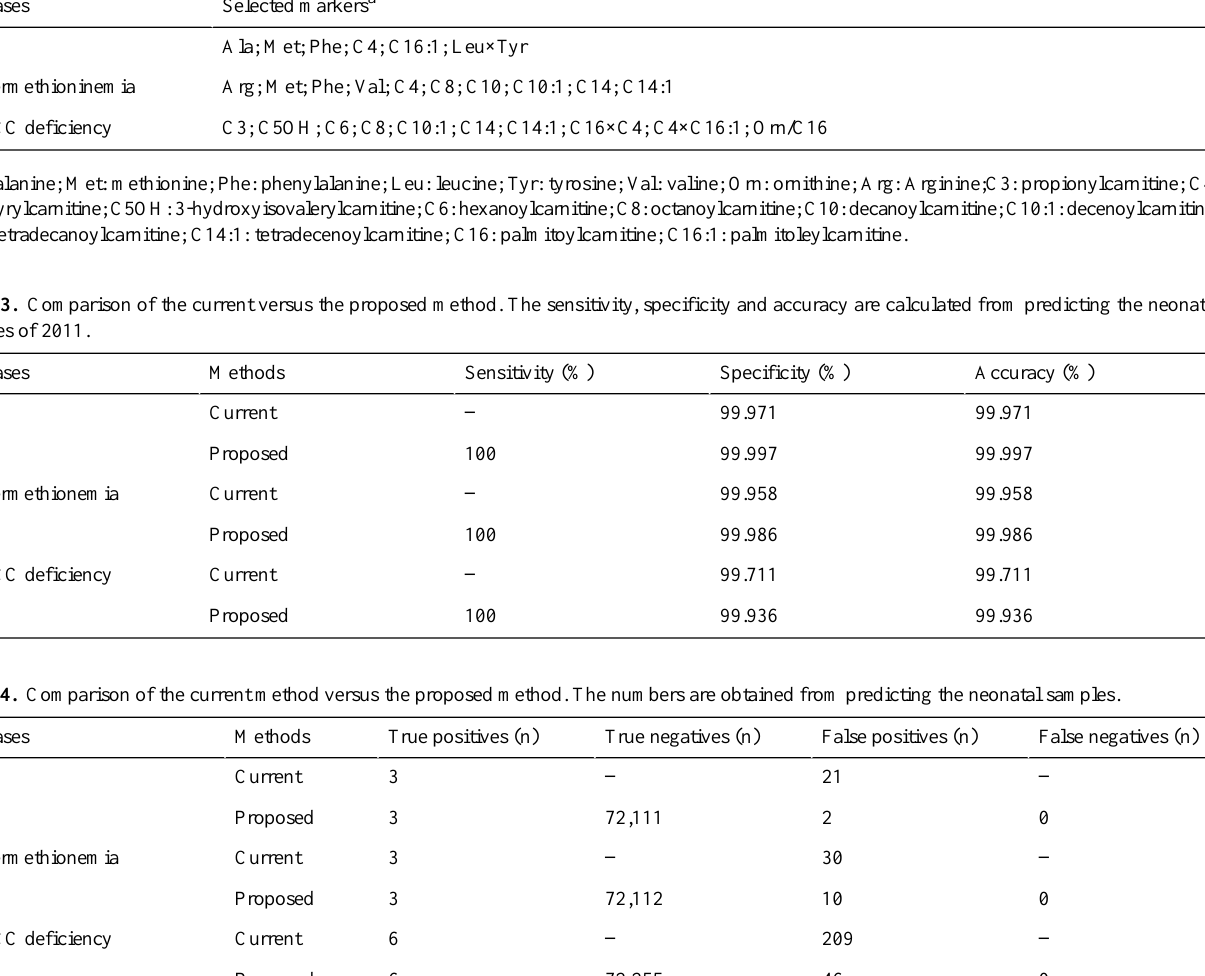
Selected markers a Diseases